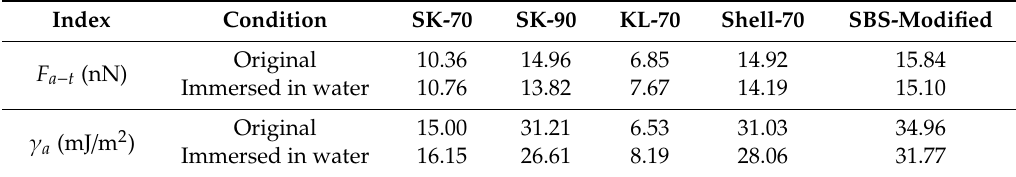
Table 6. The overall surface energies of the di ff erent asphalts before and after immersion in water.